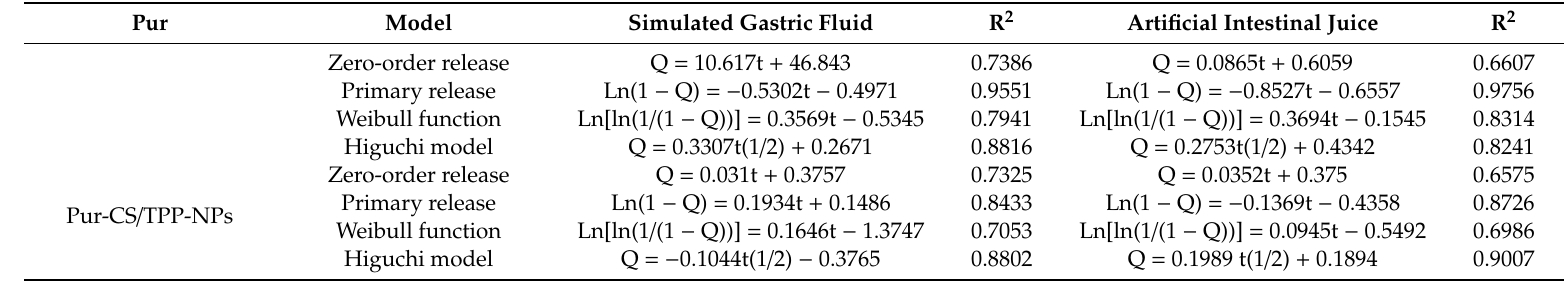
Table 5. Formula for fitting in vitro release of Pur and Pur-CS / SA-NPs under artificial gastric juice and artificial intestinal juice ( n = 3, x ±